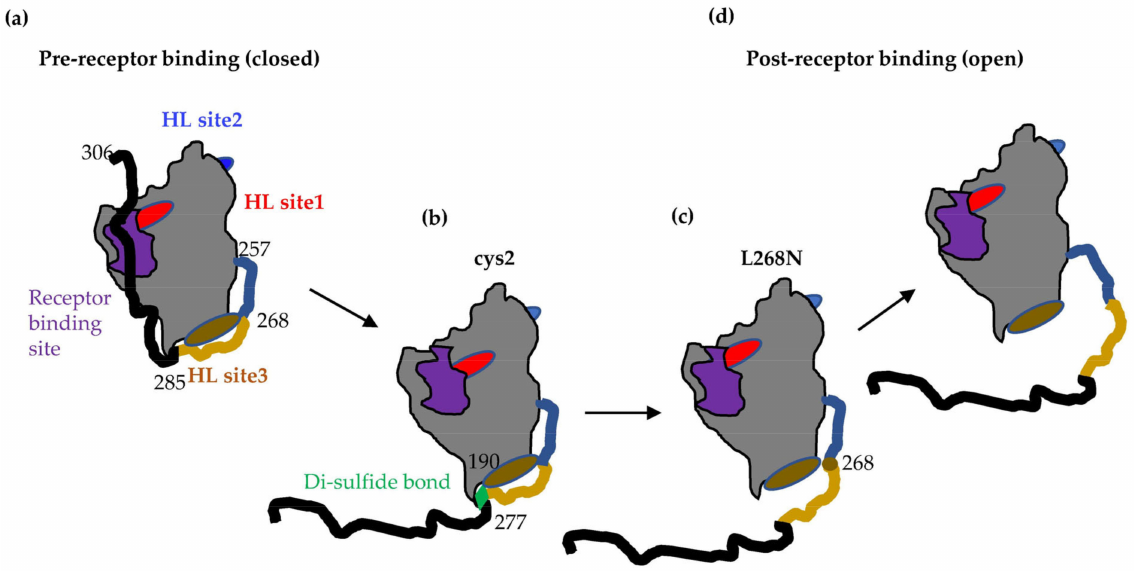
Figure 7. Proposed intermediates for the transition of gD from a pre-receptor (closed) to post-receptor binding state (open). ( a ) Before binding to a receptor, gD is in a closed conformation, with the receptor binding site (purple) covered by the C-term (black). The three gH/gL binding sites are also shown in red (site 1), blue (site 2), and brown (site 3). ( b ) In the presence of receptor or antibodies that compete with the receptor for binding, the C-term is displaced to expose the receptor binding site. Residue 277 is one inflection point in the C-term that is sufficient for receptor binding, but not gH/gL interaction. ( c ) Access to gH/gL binding site 3 (brown) is controlled by a second inflection point at position 268. Mutagenesis of this residue results in a molecule that partially exposes the gH/gL site 3. ( d ) After opening of gD past residue 268, gD is in a fully open conformation that can bind